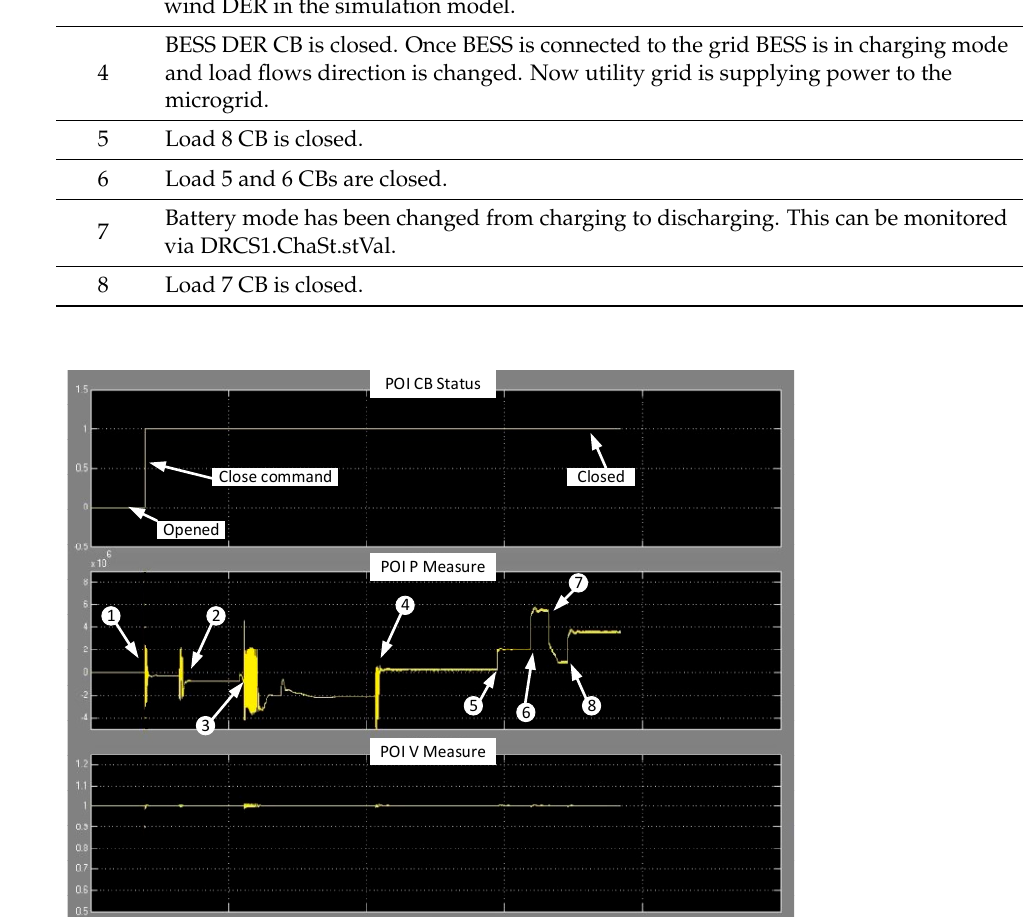
Figure 7. Blackstart case study using IEC 61850 adapter (OPAL-RT screen).